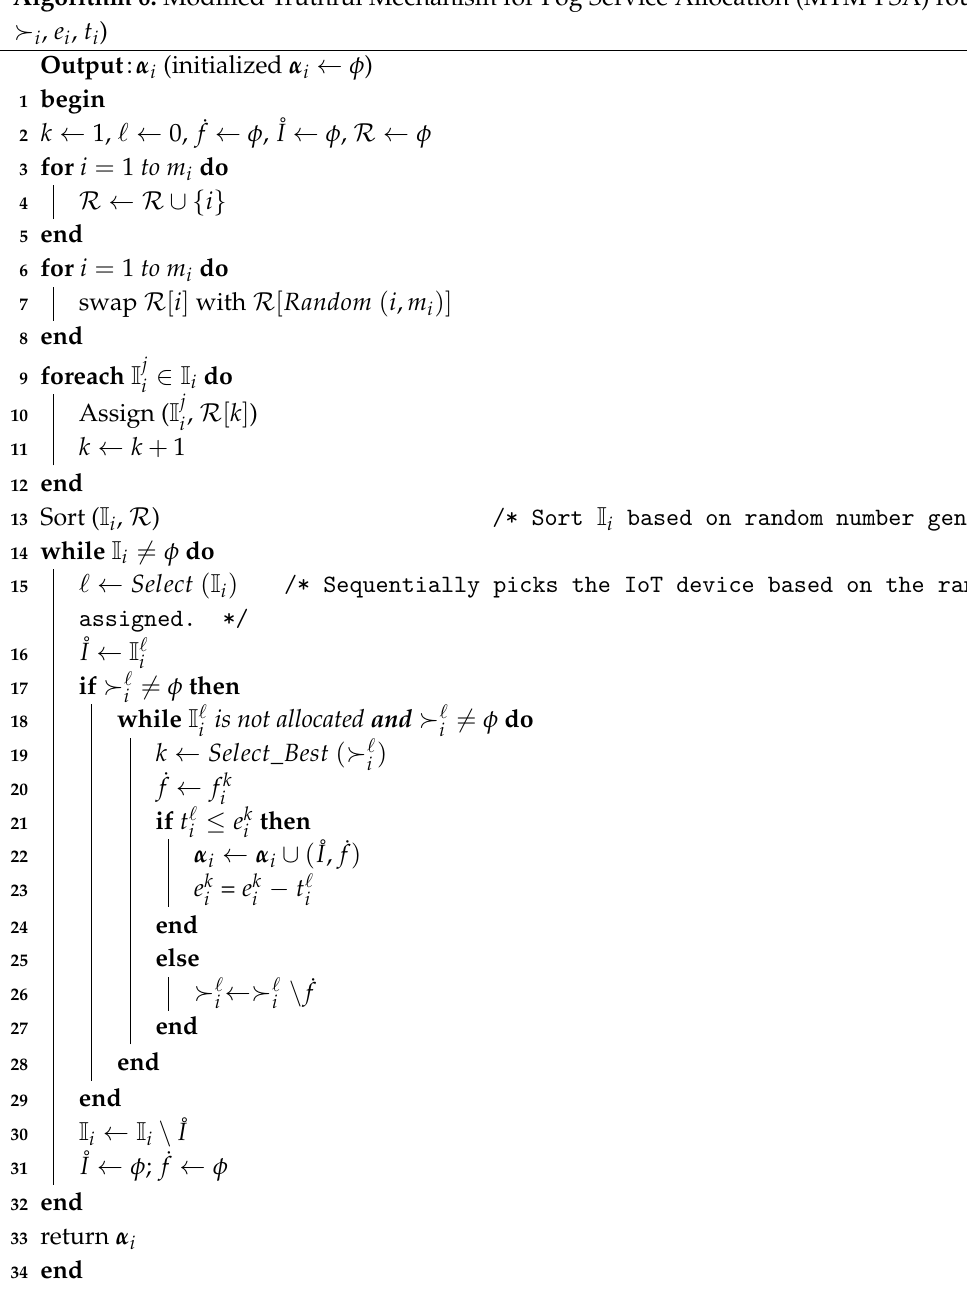
Algorithm 6: Modified Truthful Mechanism for Fog Service Allocation (MTM-FSA) routine ( f i , I i